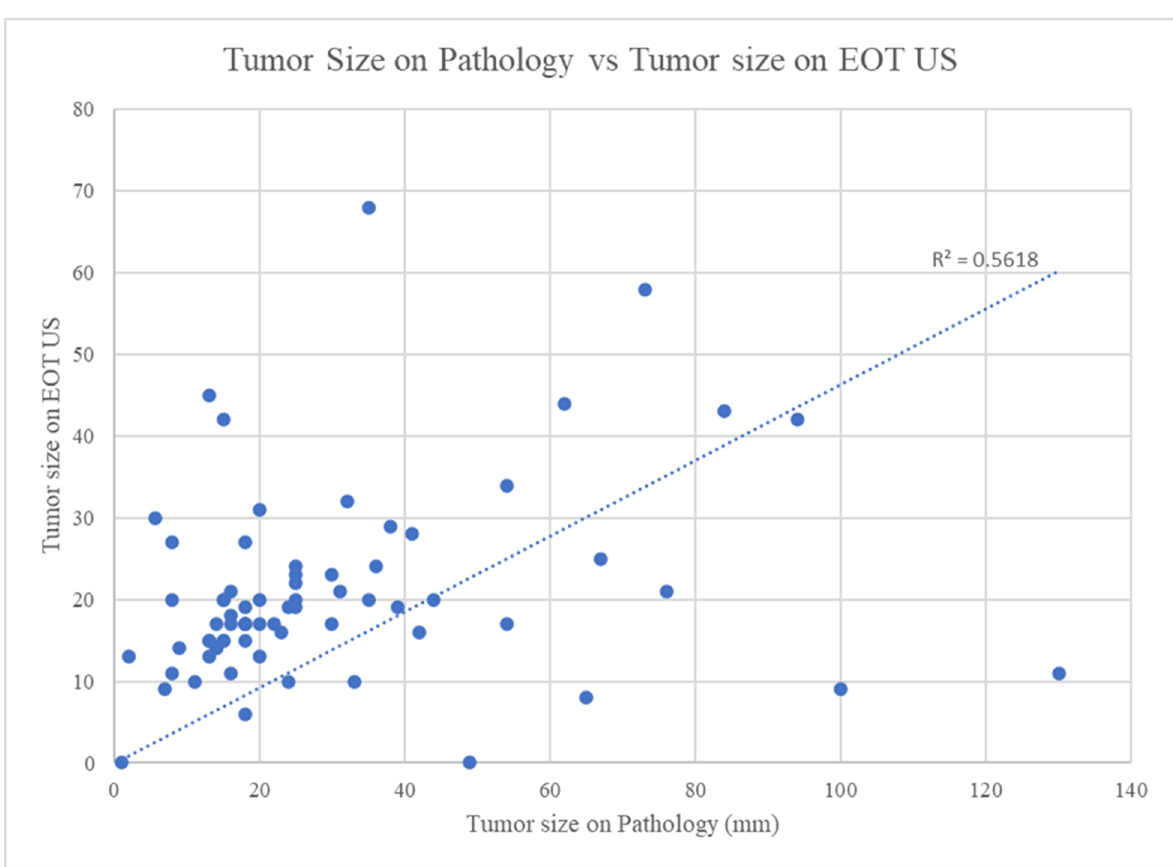
Figure 4. Comparison of the greatest dimension of tumor size on pathology (mm) to tumor size as determined by the greatest dimension on EOT US (mm). Tumor size on pathology correlates with tumor size on EOT US ( p = 0.024). EOT = End of treatment; US = Ultrasound.